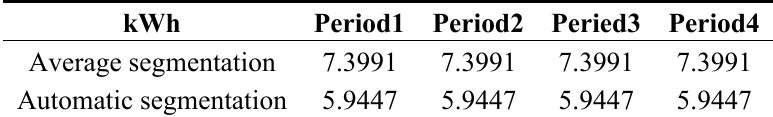
Table 4. Capacity of ESS with average segmentation method and automatic segmentation method.